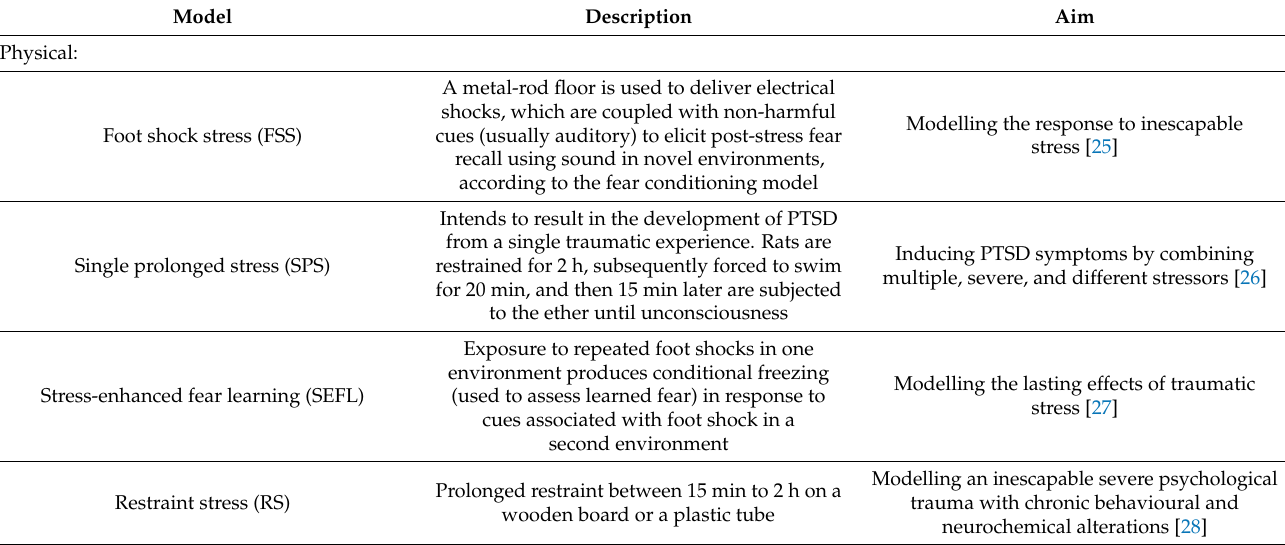
Table 1. Summary of the commonly used preclinical animal model in